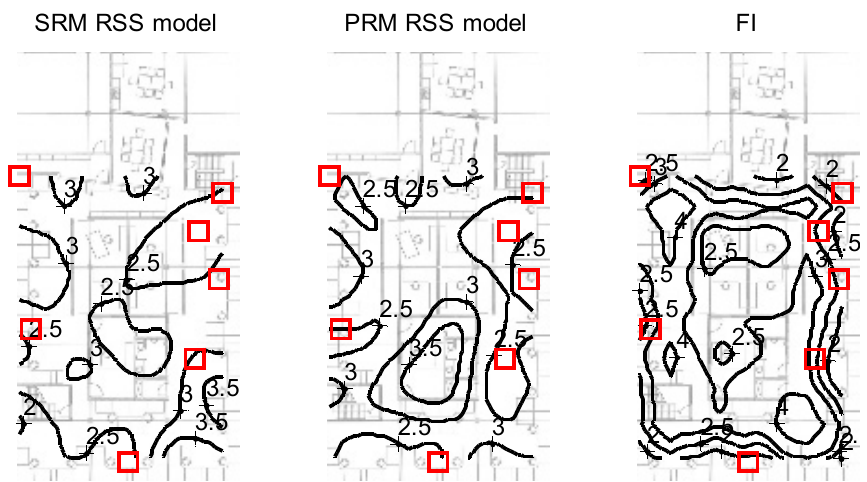
Figure 16. Evaluation of the MWD location error for a selection of 2.4 GHz APs indicated by the red squares. The left and middle plots are the estimation deviation based on the sampled radio map (SRM) and parametric radio map (PRM) respectively while the right side plot is the estimation deviation as calculated based on the Fisher Information Matrix (FIM).